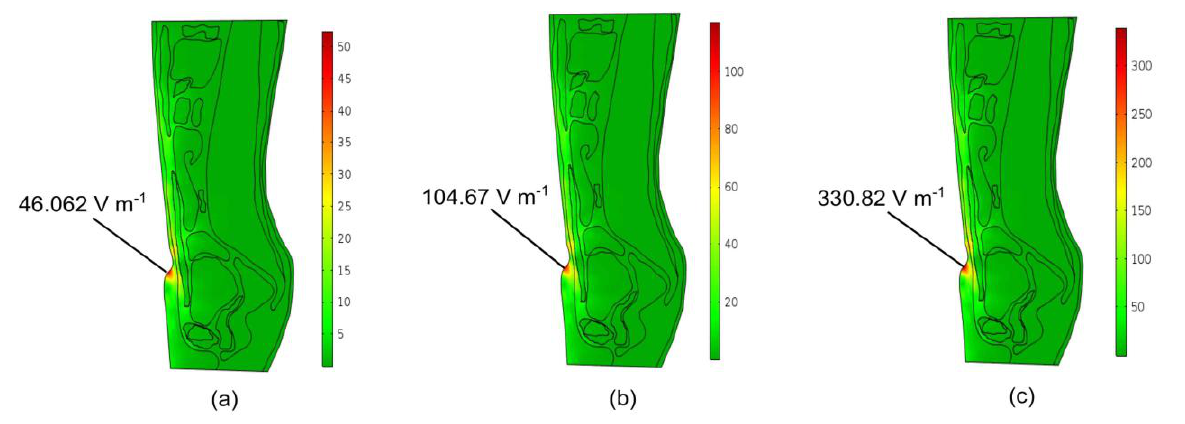
Figure 5: Electric field distribution in human trunk exposed to 2450 MHz plane wave at (a) 1 mW cm -2 , (b) 5 mW cm -2 and (c) 50 mW cm -2